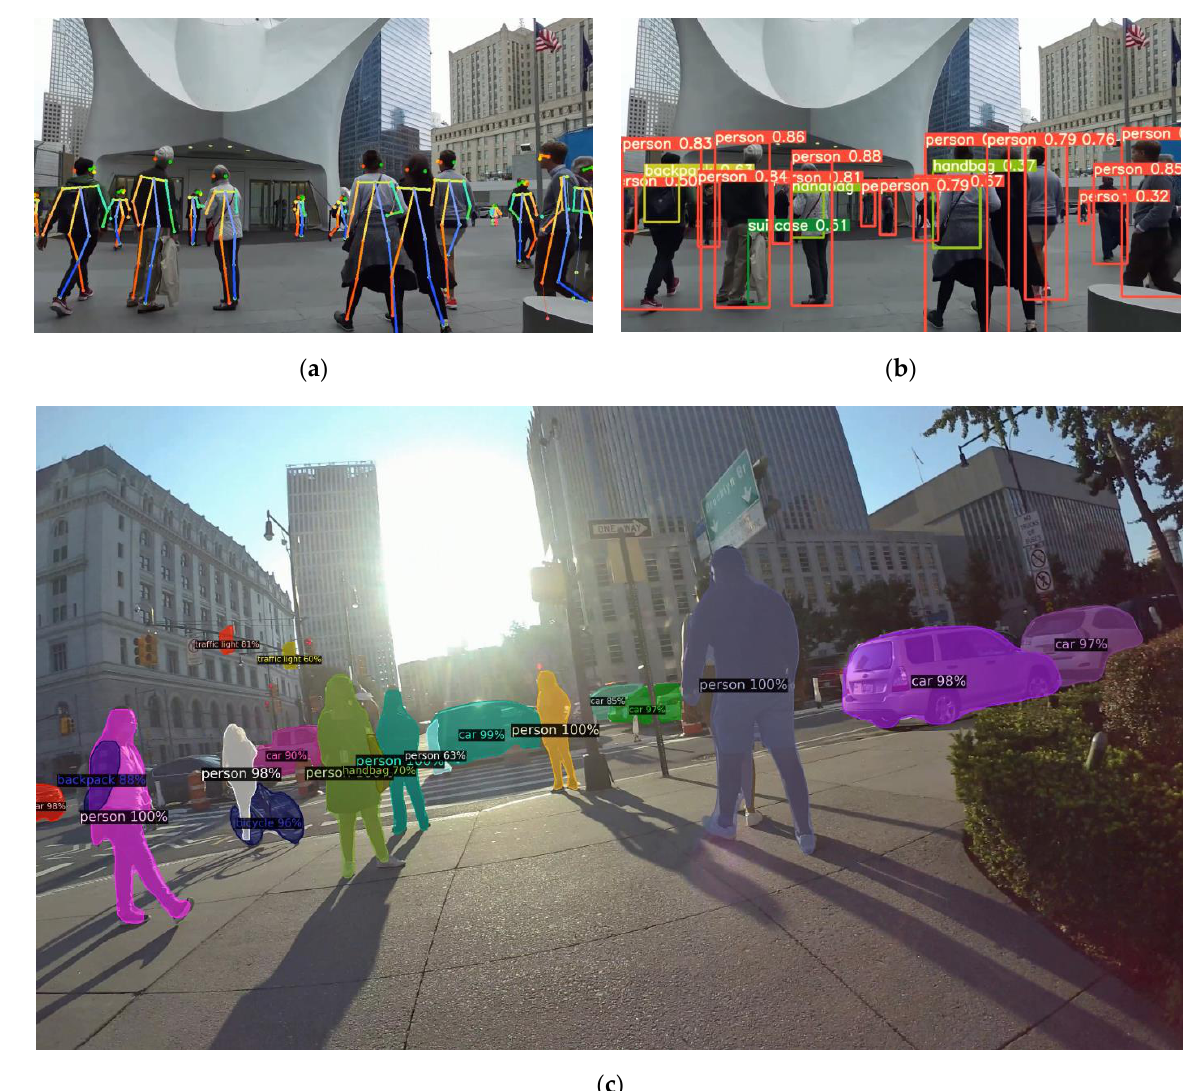
Figure 11. Automatic and dynamic detection of streetscape features, objects, and people. ( a ) Pedes- trian and pose detection with Openpose . ( b ) Pedestrian and object detection with YOLO . ( c ) Pedestrian, vehicle, infrastructure, and object detection with Detectron2.